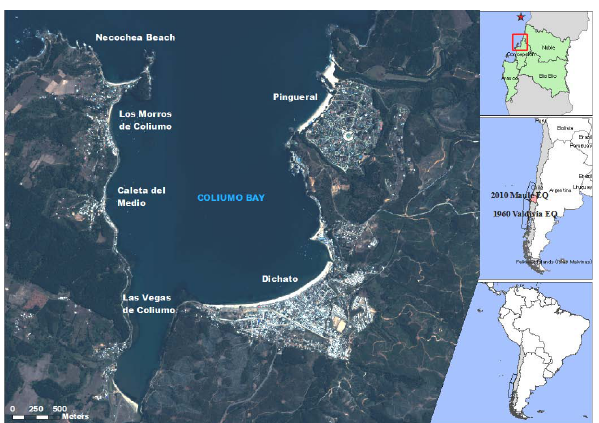
Fig. 2. Location of the ten-story apartment buildings and surrounding